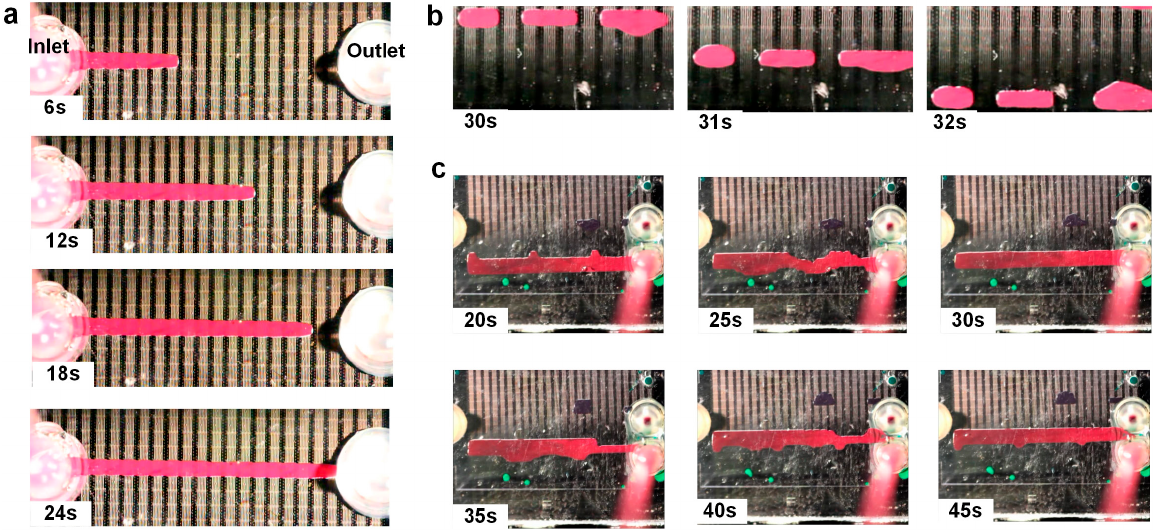
Figure 4. ( a ) Electrodes were turned on in a straight line connecting the inlet and outlet ports. Red fluid introduced using a syringe pump forms a channel. ( b ) Three droplets of three different sizes were created by splitting. These droplets were then moved